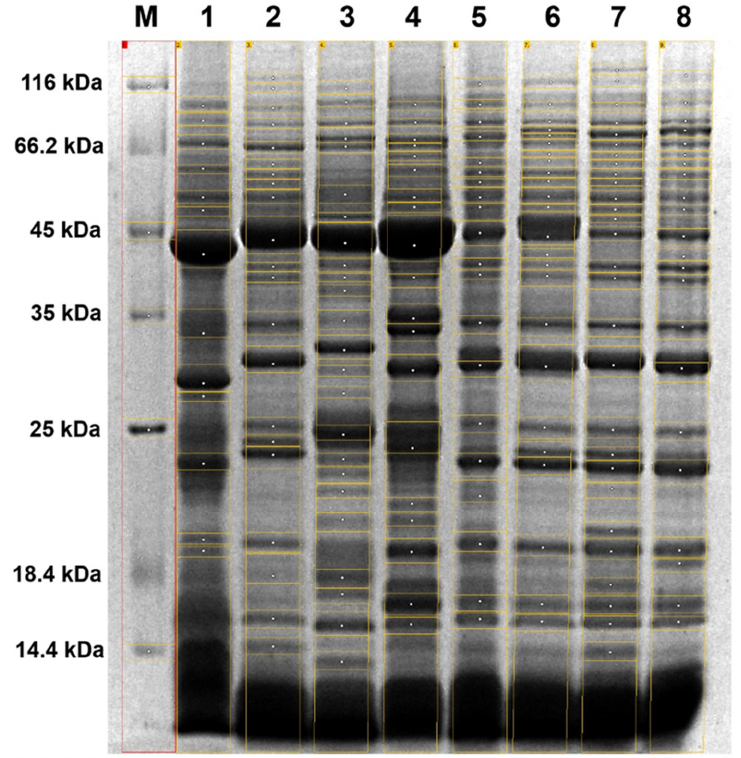
Figure 1. Representative SDS-PAGE image showing seed total protein (STP) profiles from the eight taxa under study. Lane 1: Abies koreana , 2: Pinus nigra Arn., 3: Pinus strobus , 4: Pseudotsuga menziesii (Mirbell) Franco, 5: Pinus sylvestris , 6: Pinus × rhaetica , 7: Pinus uliginosa , 8: Pinus mugo , M: Unstained Protein Molecular Weight Marker (14.4 kDa–116 kDa; Thermo Fisher Scientific,